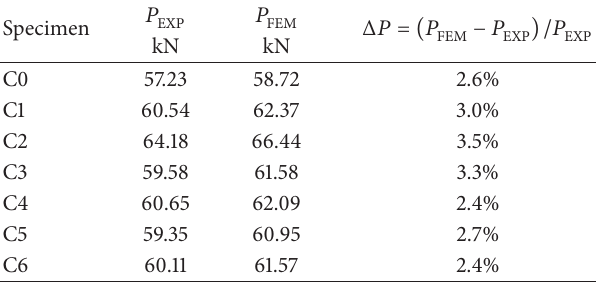
Table 3: Comparison of buckling load capacity of